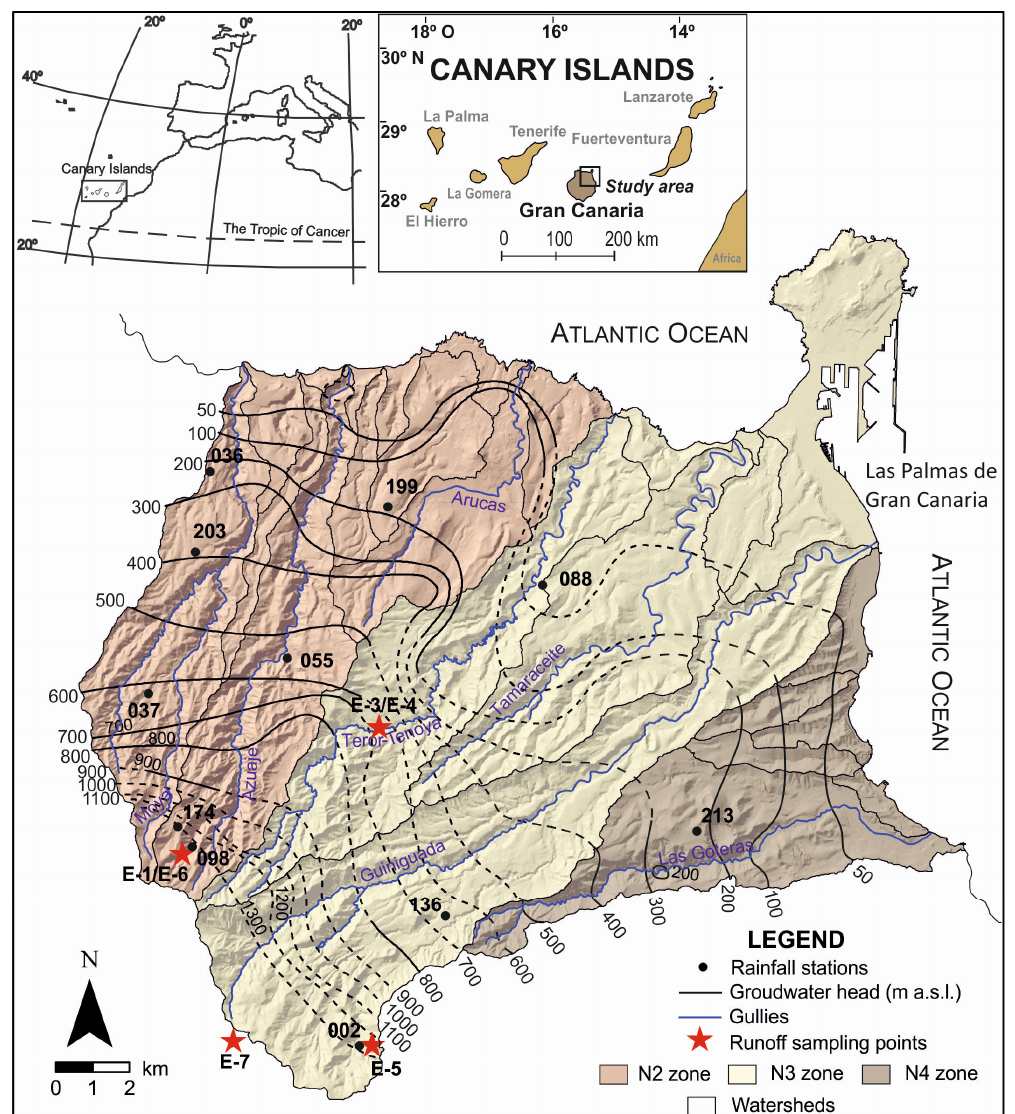
Figure 1. Study area, location of rainfall stations, where samples were collected, and runoff sampling points. Groundwater head contours (2008–2009), modified from [26,27]. The island aquifer is conceptualized as a single, stratified heterogeneous water body, with groundwater flowing from recharge areas at high altitude in the central part of island toward the coast. Natural discharge is produced along the coast, which took place through springs at gully bottoms in the past, but currently occurs by means of wells and water galleries. Groundwater is recharged and flows through different rock formations on the island, which are hydraulically connected and actually form a single, but heterogeneous, island aquifer system [28]. There are some exceptions, such as the La Aldea aquifer in the western part of the island, which is hydrogeologically isolated from the rest of the island [29] and only receives surface water inflow from three storage reservoirs upstream through a deep narrow